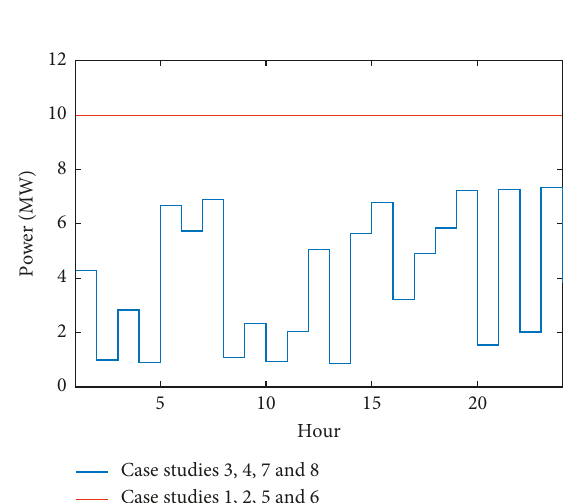
Figure 8: Maximum power exported to the grid for cases 3, 4, 7, and 8 and for cases 1, 2, 5, and 6.